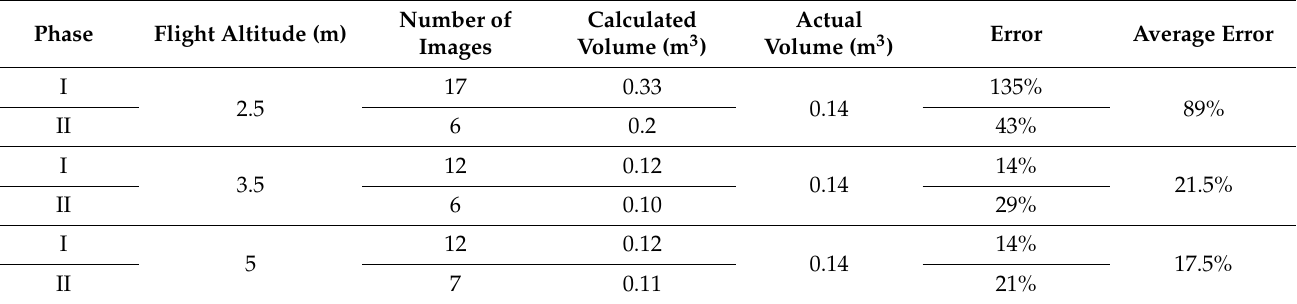
Table 3. Validation of Volume Calculations from Laboratory